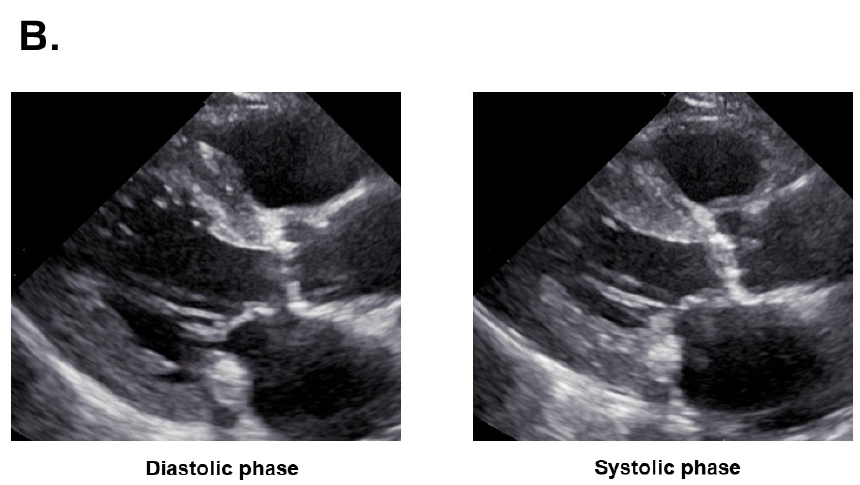
Figure 2. Transthoracic echocardiography (long-axis view) at diastolic/systolic phase on admission expressing left ventricular ejection fraction of 25% ( A ) and those following 3-month medical therapy showing left ventricular ejection fraction of 36% ( B ).